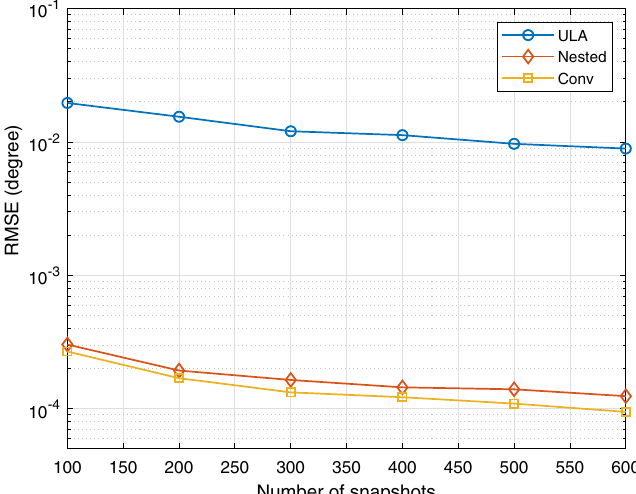
Fig. 5 MUSIC spectrum of the sparse convolutional array, nested array and uniform linear array, SNR